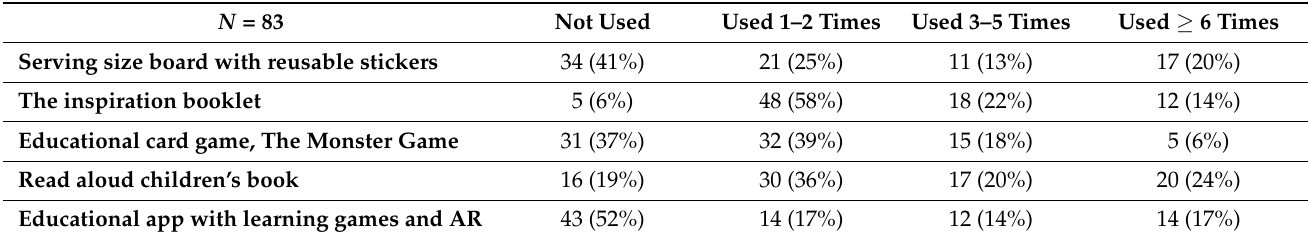
Table 2. Frequency of use of materials among participating families.